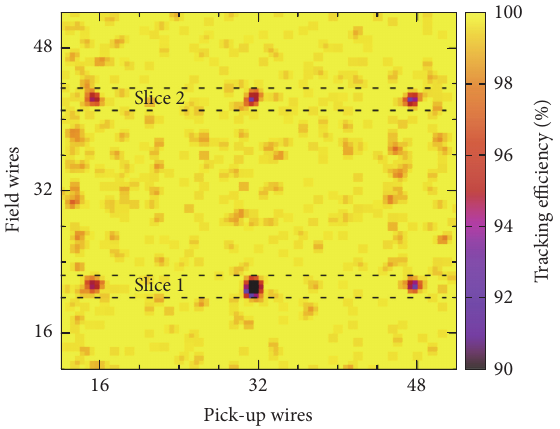
Figure 8: Efficiency map covering the region of the support pillars. Thereductionissmallandlocalized(notethezerosuppressedscale).